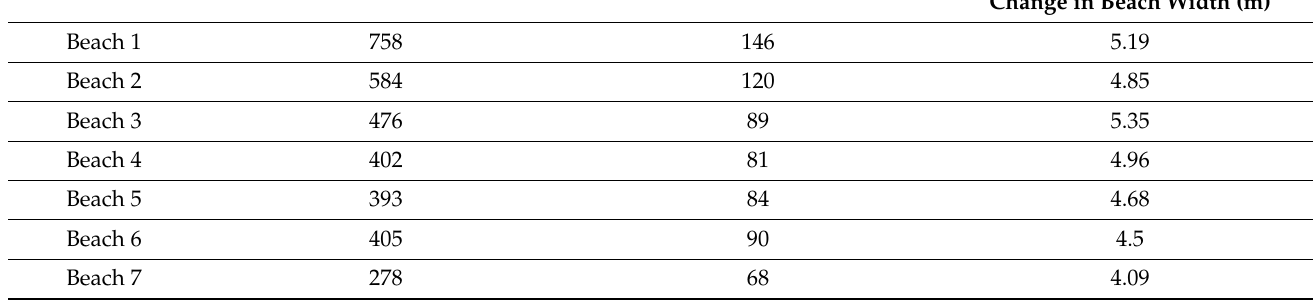
Table 2. Cross-section area of shingle beach deposits between 1940 and 2019 derived from GPR profile, the width of the beach accretion between 1940 and 2019, and the average thickness of shingle derived by dividing the cross-sectional area by the width of accretion. Average Thickness of Shingle at Cross-Section of Beach from Increased Width of Beach from Each Profile Derived by Dividing GPR (m 2 ) Historic Images (m) (1940–2019) the Cross-Section Area by the Change in Beach Width